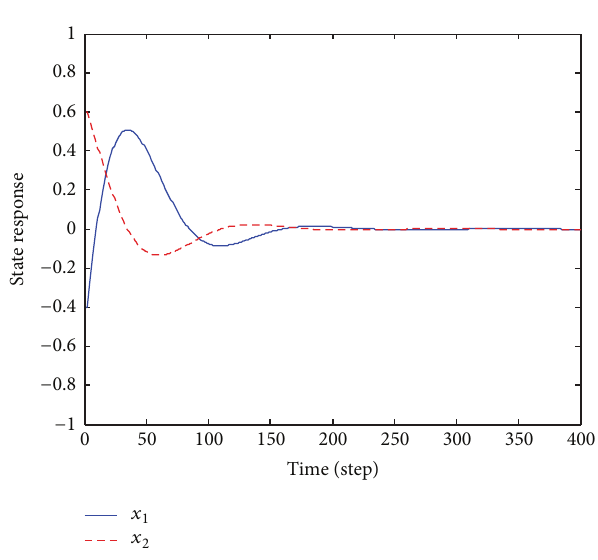
Figure 4: S-C random delays 𝜏(𝑘) .